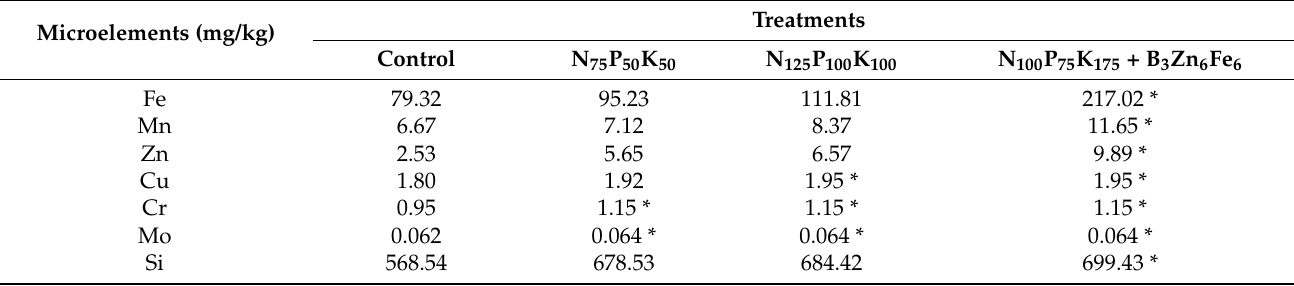
Table 2. The impact of mineral fertilisers on microelement content of turmeric rhizome grown in soil–climate conditions of Tashkent